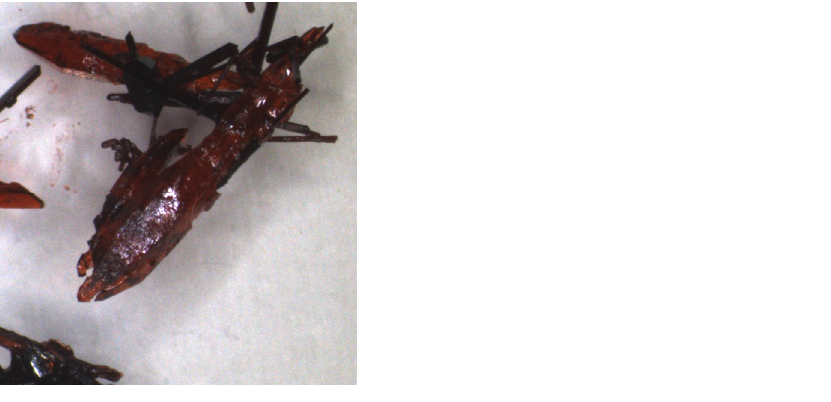
Figure 3. Photo of crystals obtained from the recrystallization of [Fe 0.4 Zn 0.6 (bpy) 3 ](PF 6 ) 2 . Dark needles = racemic crystals, ruby needles = conglomerate crystals.